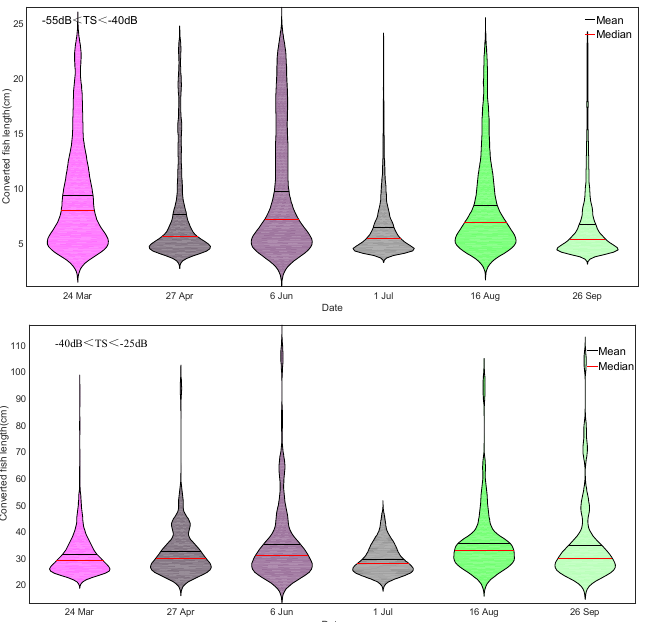
Figure 6. Converted fish length distributions in different TS groups. The vertical length and the horizontal width of each violin graph represent the distribution range of converted fish length and the probability density, respectively. The black and red horizontal lines represent the mean and median of the data distribution, respectively, and the rectangular area between the lines indicates the inter-quartile range.